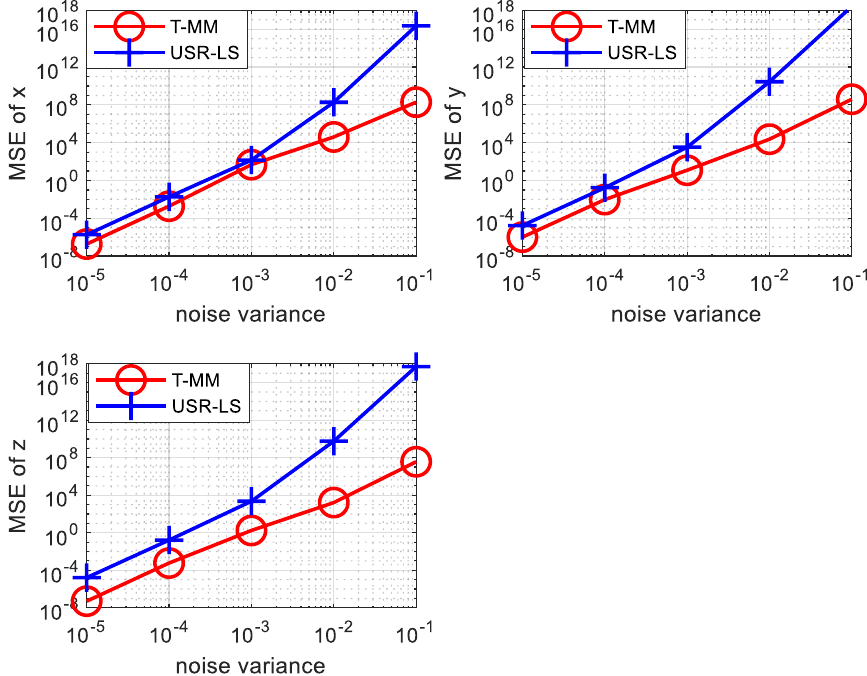
Figure 10. T-MM’s MSE comparison to the USR-LS’s MSE versus noise variance in 3D scenario over the bellhop underwater channel model.